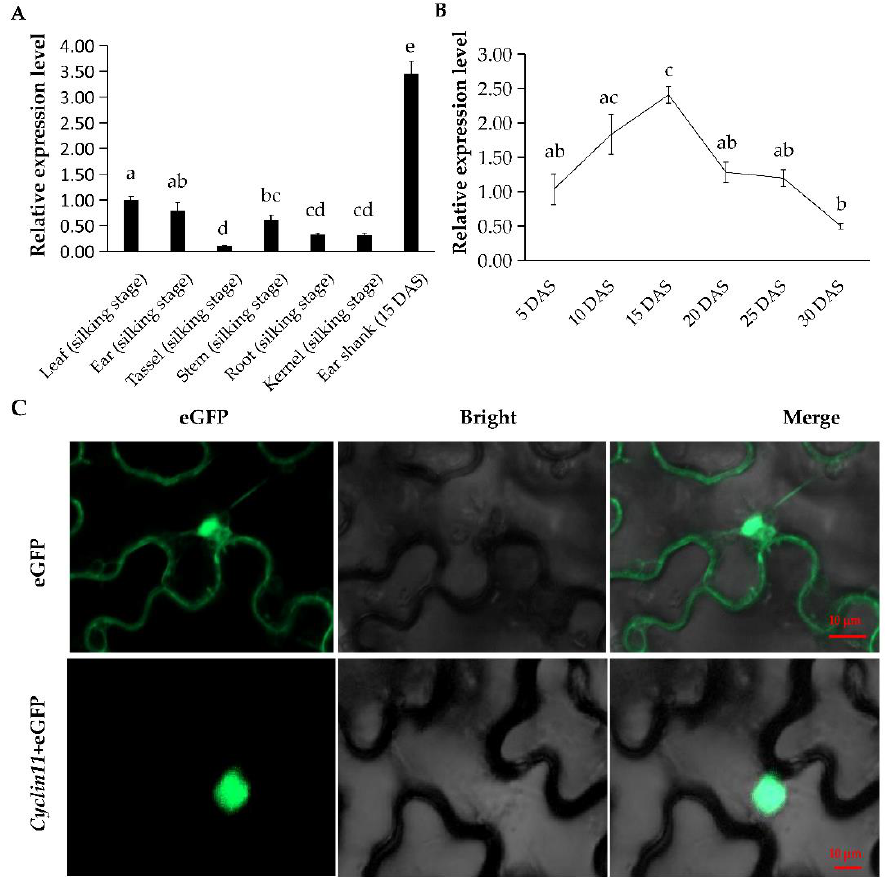
Figure 5. Temporal and spatial expression profile of Cyclin11 . ( A ) Cyclin11 expression level in different tissues of maize. Different small letters above the columns indicated significant ( p ≤ 0.05) differences between various tissues. ( B ) Cyclin11 expression level in different developmental stages of ear shanks. Different small letters above the columns indicated significant ( p ≤ 0.05) differences between various developmental stages. ( C ) Subcellular localization of the Cyclin11 protein in tobacco leaves, Scale bar 10 μm ). DAS, day after silking.